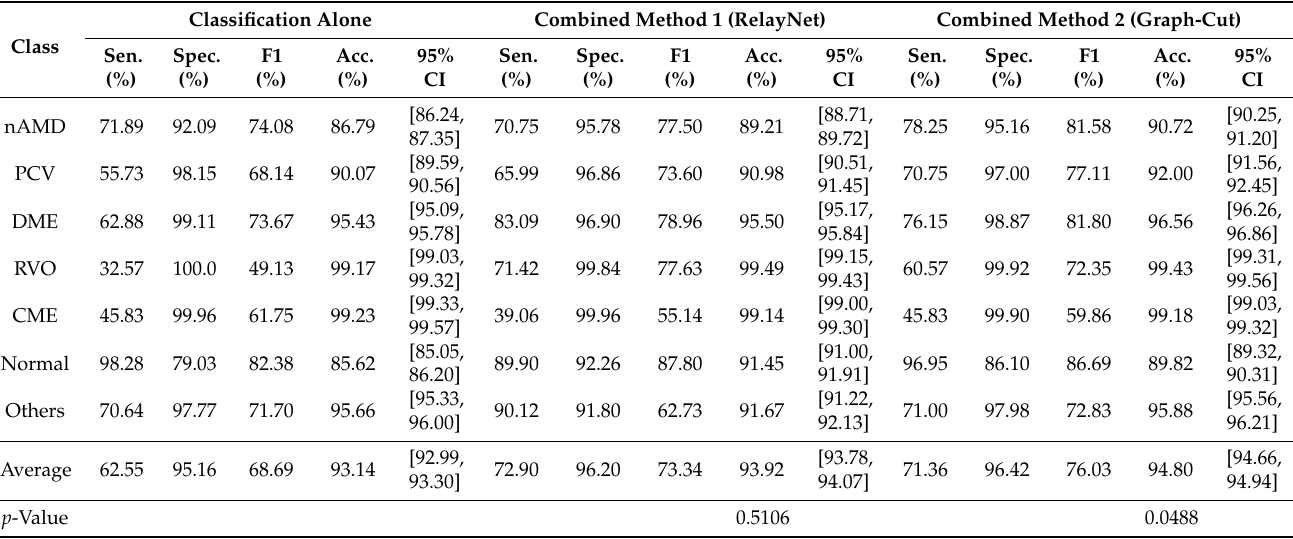
Table 2. Performance of the three models using the testing set: classification alone, combined method 1, and combined method 2 in the classification of the macular